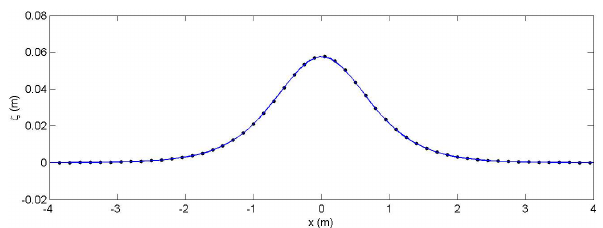
Fig. 11. Water surface profiles of a solitary wave with 0.058m wave height propagating in constant water depth of 0.32m: profile at t =0 ( (cid:5) ) compared with that at t =60s shifted leftward in 114.97m